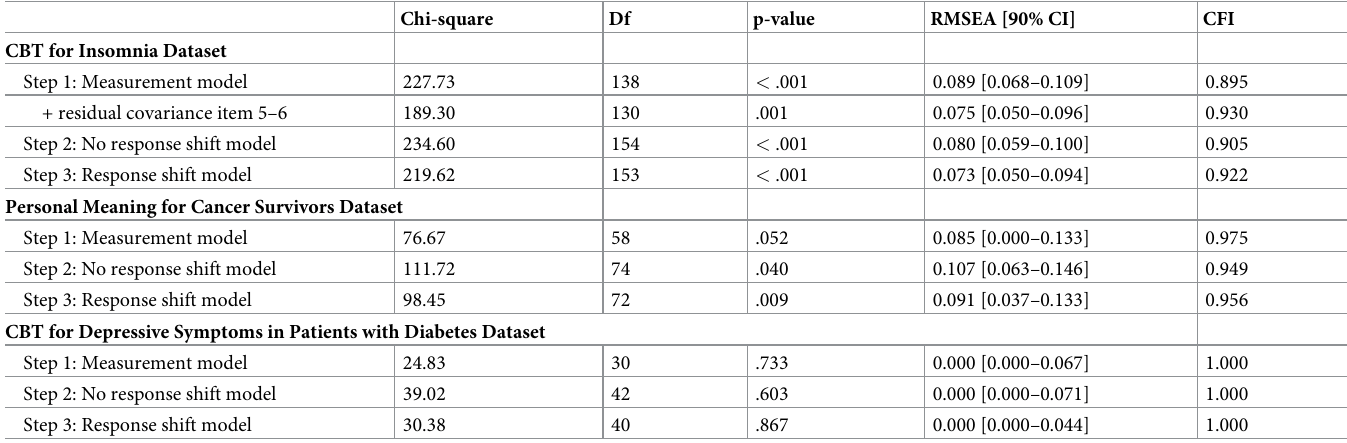
Table 4. Overall goodness of fit of the models in steps 1–3 of the SEM-approach for investigation of response shift (objective 1) for each of the three datasets. Chi-square